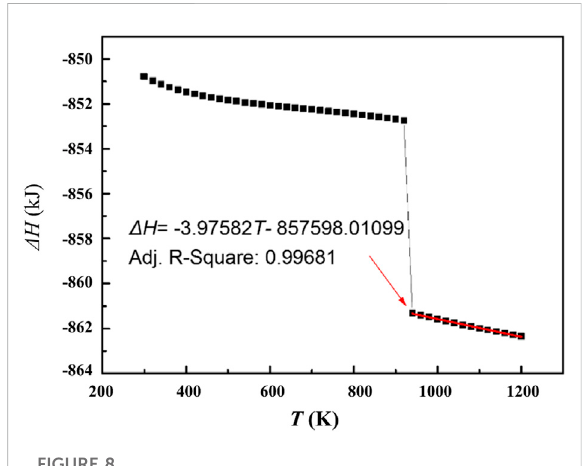
FIGURE 8 The heat release of magnesium oxidation as a function of